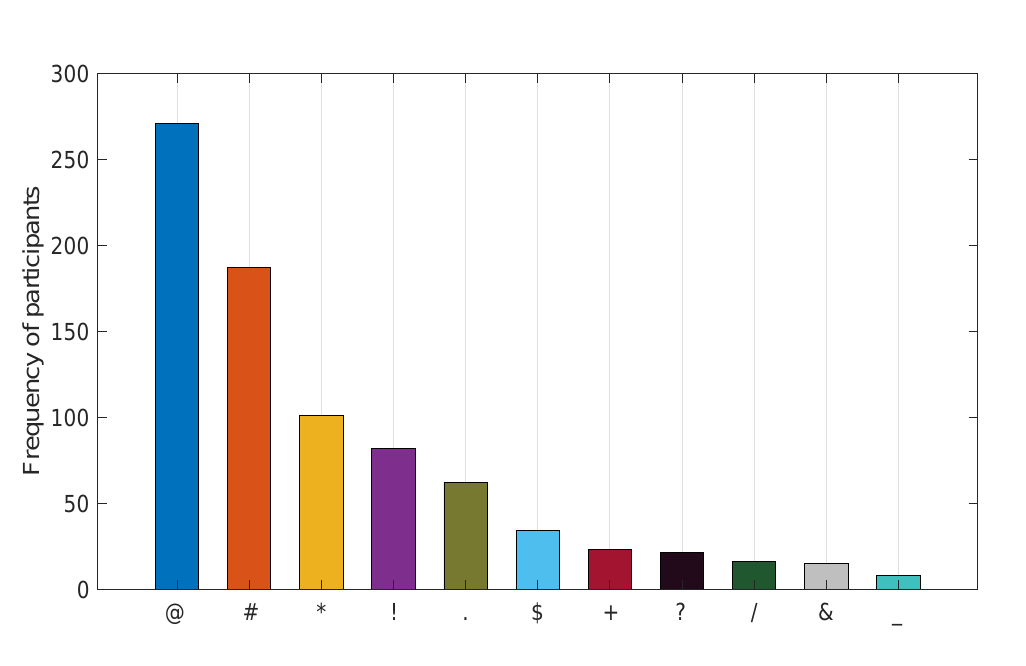
Figure 6. Most frequently used symbols in passwords